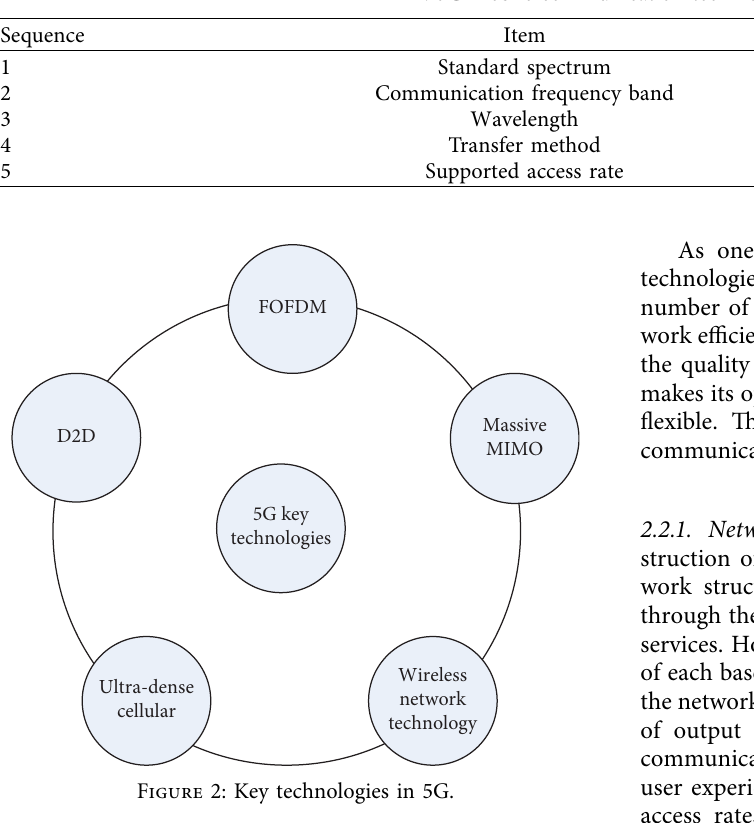
Figure 1: 5G mobile communication technology basic structure. Table 1: 5G mobile communication technical parameters.